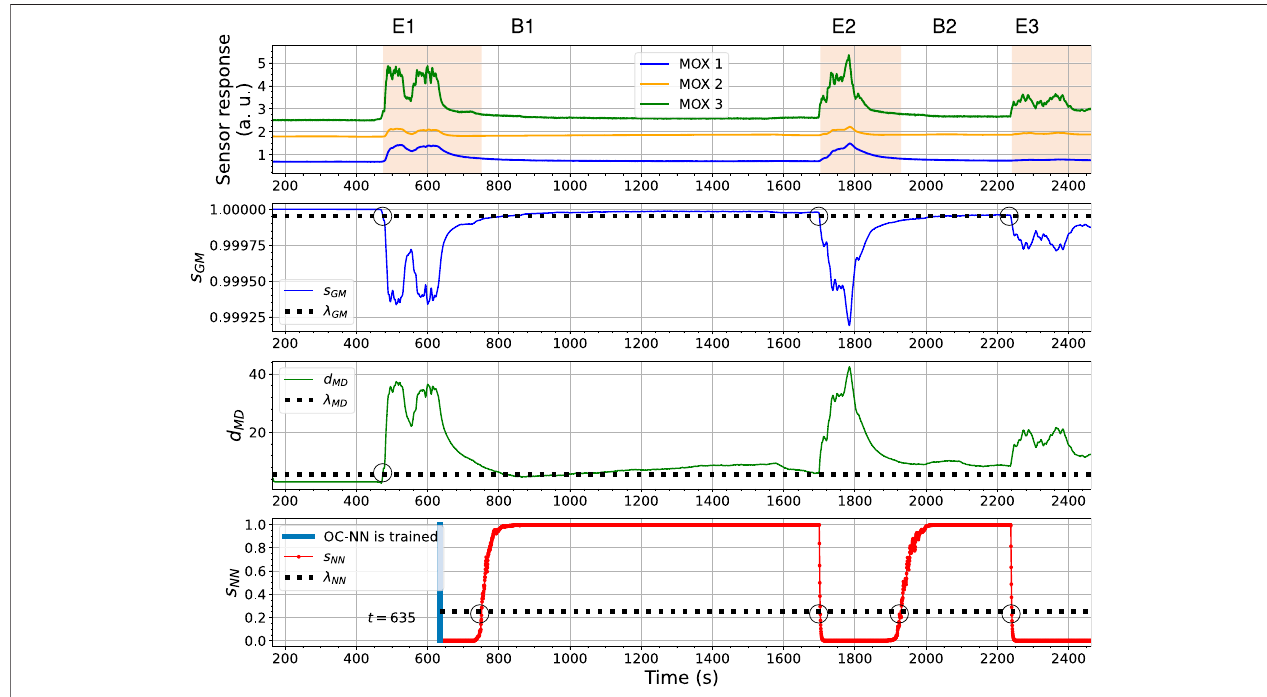
FIGURE12| The output changesoftheOC-Gaussian,theOC-Mahalanobis, andtheOC-NNmodels using FireNose intheExp. 3-sourcetrial.Thegasresponses recognized by the ensemble model are in red shade in the sub- fi gure at the top. The meanings of E1, B1, E2, B2 and E3 are explained in the text.